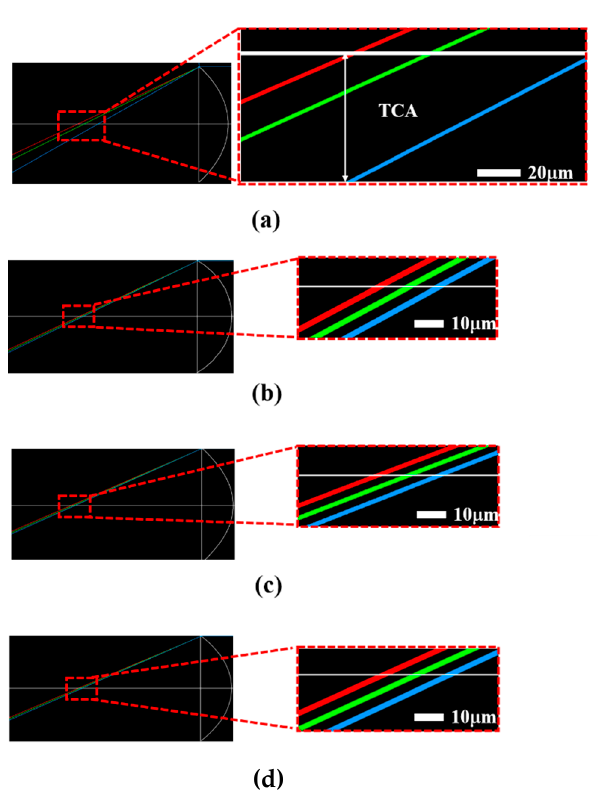
Figure 8. ( a ) Simulation results for TCA analysis with the wavelength-dependent ray distributions for the plano-convex microlens array with the lens-curvature air interface, where the isotropic polymer of NOA81 was assumed as the optical material of the lens layer. ( b – d ) Simulation results for TCA analysis with wavelength-dependent ray distributions for the high- Δ n LC GRIN lens array with different interfacial curvatures, where LCM 1107 and NOA81 were assumed as the plano-convex birefringent and plano-concave isotropic layers, respectively: ( b ) spherical, ( c ) quadratic polynomial aspherical, and ( d ) high-order (fourth-order) polynomial aspherical curvatures. The red, green, and blue lines present the ray distributions of λ = 630, 550, and 450 nm wavelength, respectively. Table 2. Wavelength-dependent TSA and TCA properties of LC-GRIN lens arrays in case of using LCM 1107 as the plano-convex birefringent layer and NOA81 as the plano-convex isotropic layer.